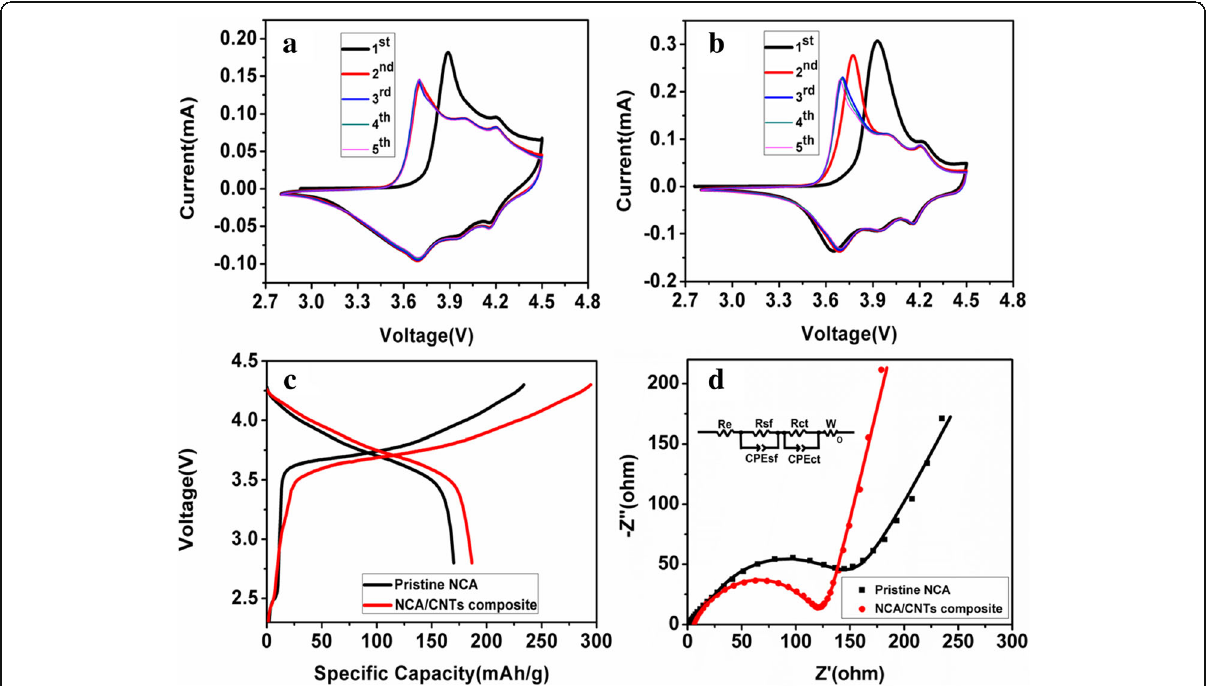
Fig. 5 Cyclic voltammograms of a pristine NCA and b NCA/CNT (10 wt%) composite. c The initial charge-discharge curves at 0.25 C rate and d Nyquist plots ( inset : equivalent circuit used to fit the experimental data) of pristine NCA and NCA/CNT (10 wt%)